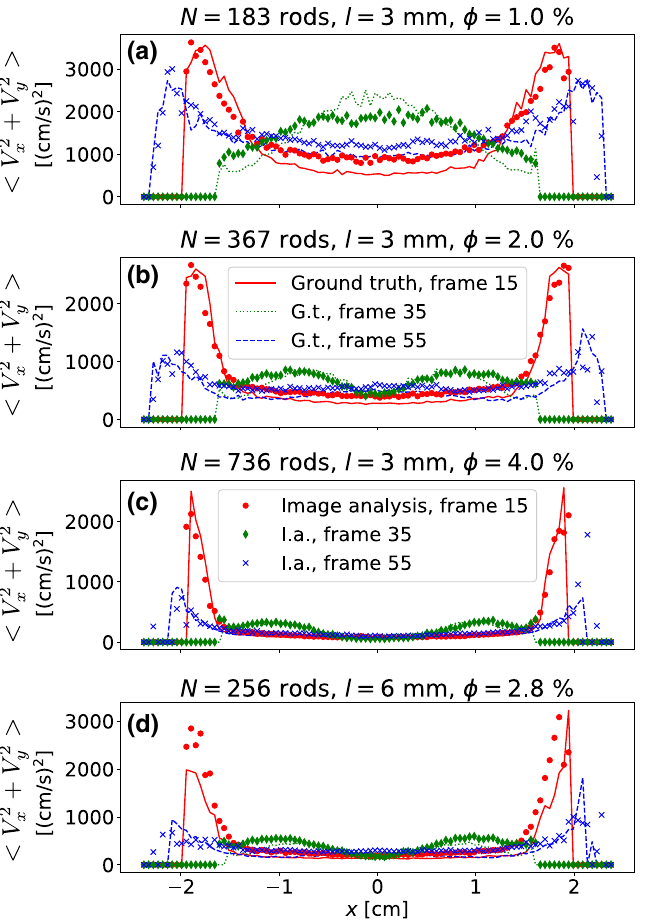
Figure 6. Calibration of mean squared velocity (kinetic energy) profiles along the coordinate x on the basis of the evaluation of synthetic images. The lines represent the ground truth , i. e. the actual mean squared velocities of the simulated ensemble. Symbols show the reconstructed distributions from synthetic images for different piston positions. Note that some fringe points in the reconstructed data may correspond to tracked features of moving pistons; those data points lie outside the momentary container volume and should be discarded in the subsequent analysis.